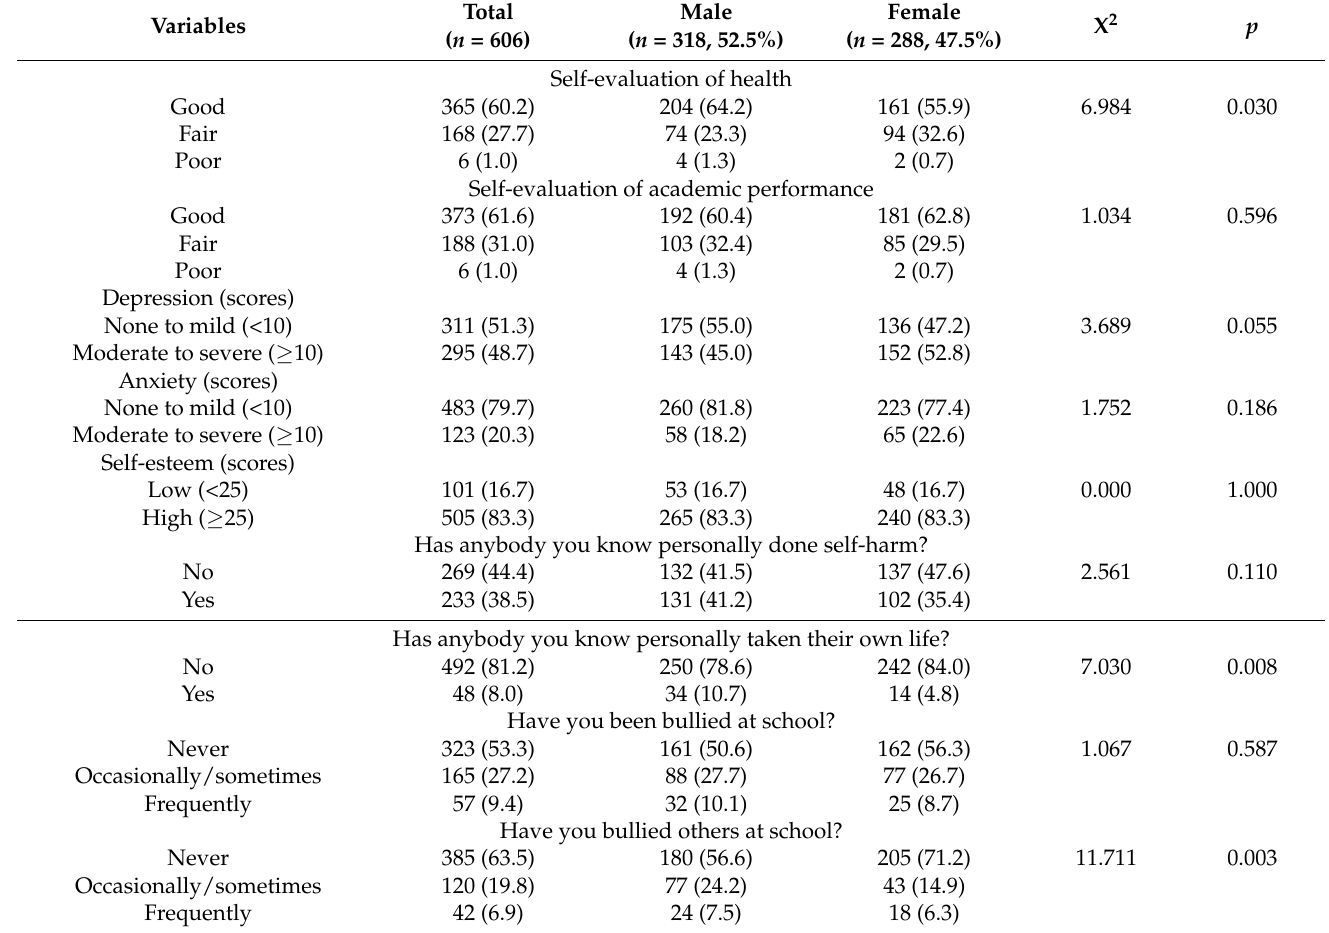
Table 2. Health and mental health for participants by